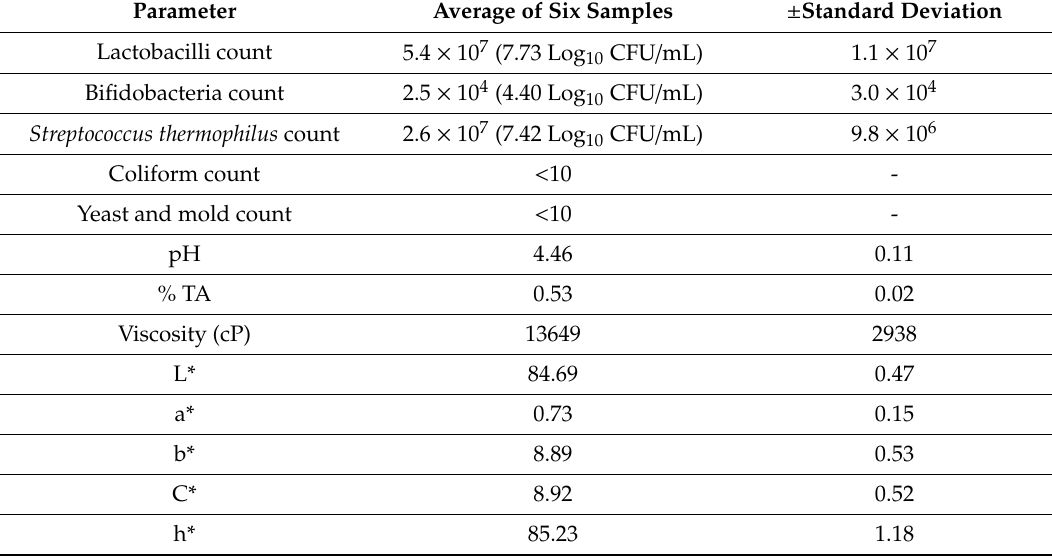
Table 1. Microbiological and physiochemical properties of